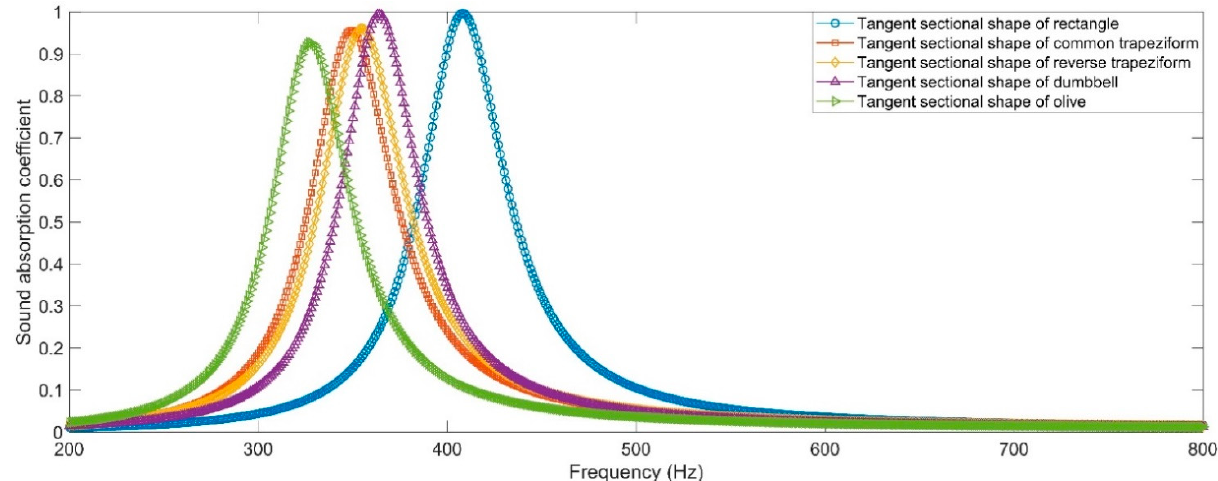
Figure 9. The sound absorption performance of HRs with the aperture for various tangent sectional shapes.